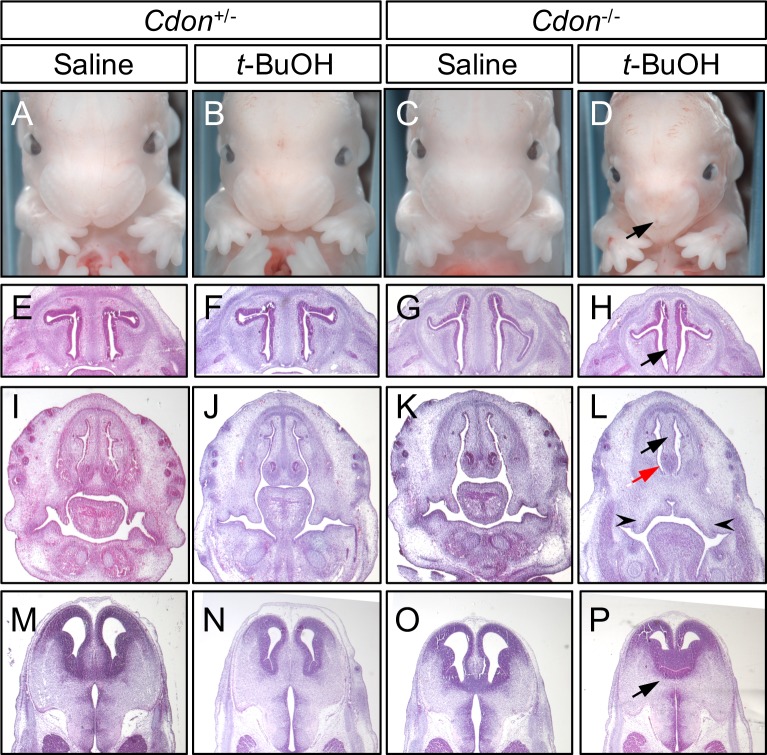
t-BuOH induces HPE in Cdon mutant mice.(A-D) Frontal views of E14 embryos. t-BuOH-treated Cdon-/- embryos (D) developed strong facial features of HPE, including single nostril (arrow). (E-P) H&E stained coronal sections of E14 embryos. Midfacial and forebrain midline structures were missing or reduced in t-BuOH-treated Cdon-/- embryos, including cartilage primordium of the nasal septum (H, arrow); nasal septum (L, black arrow); vomeronasal organ (L, red arrow); defective palatal shelves (L, arrowheads) flanking midline cleft; and ventral diencephalon midline structure (P, arrow).